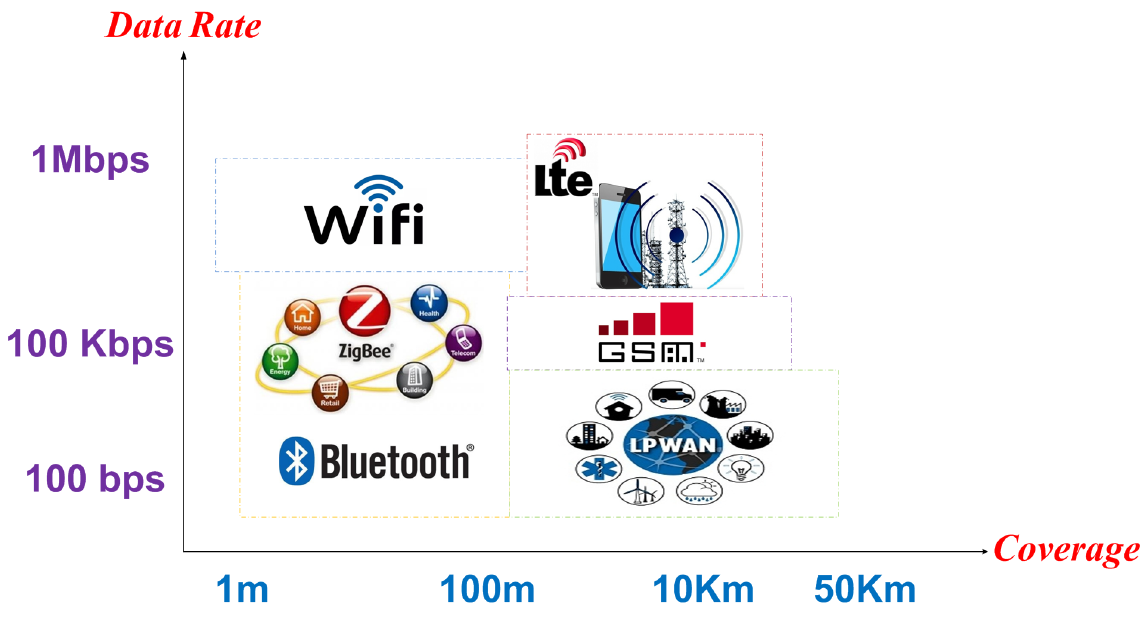
Figure 1. Relationship between coverage and data rate for various wireless communication